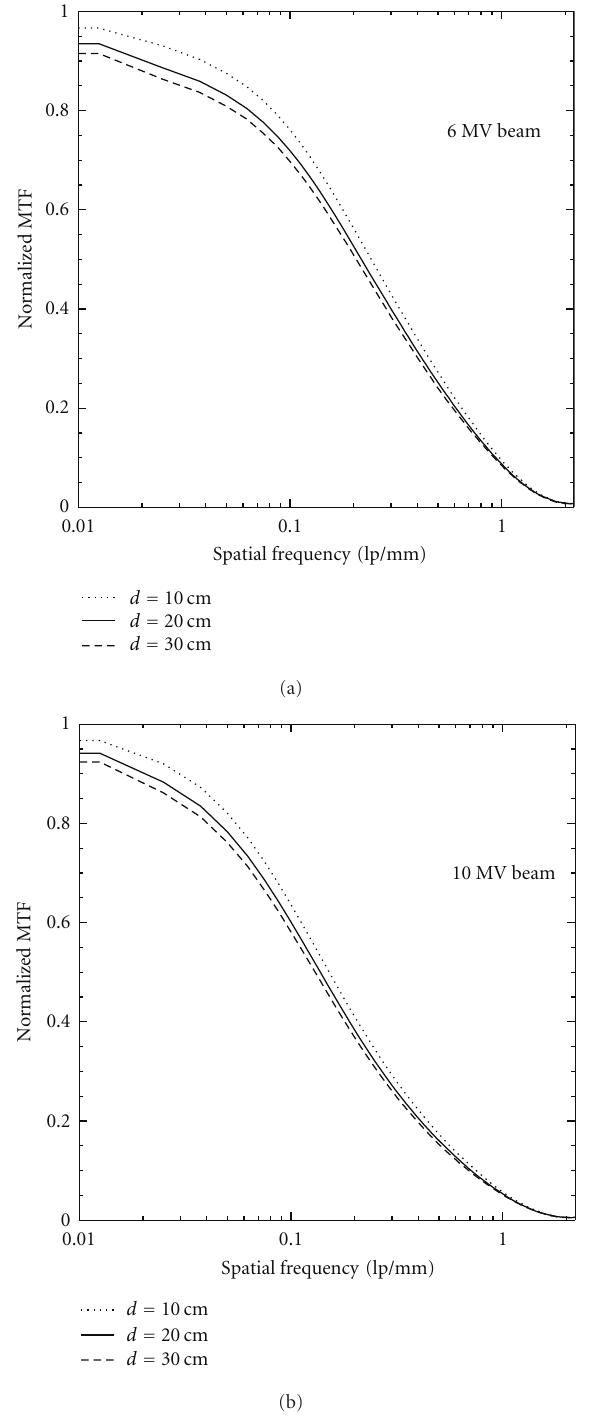
Figure 5: The MTF as a function of spatial frequency for various thicknesses of the proposed CPID. The entrance spectra of X rays from Figure 2 were used in the simulation.